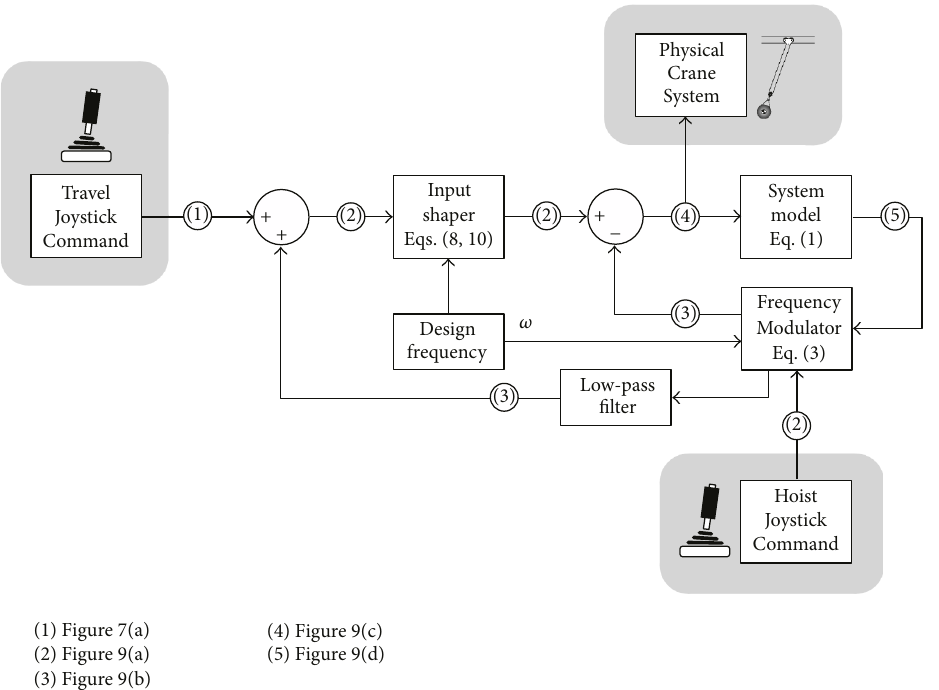
Figure 8: Schematic block diagram of the modified frequency modulation input